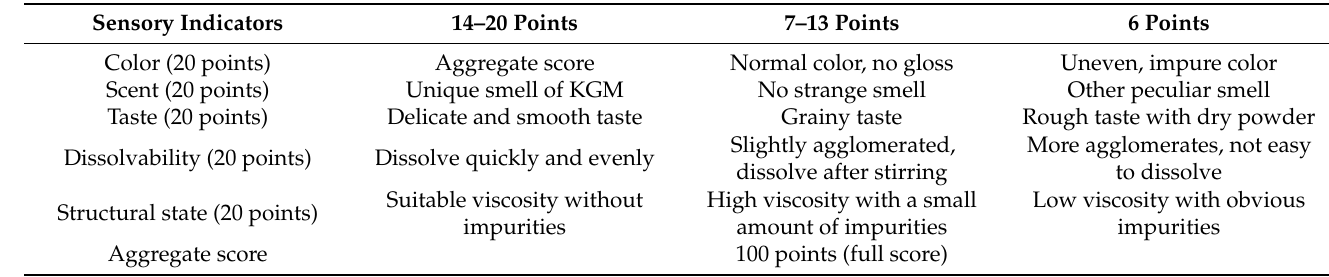
Table 1. Standard for sensory evaluation.